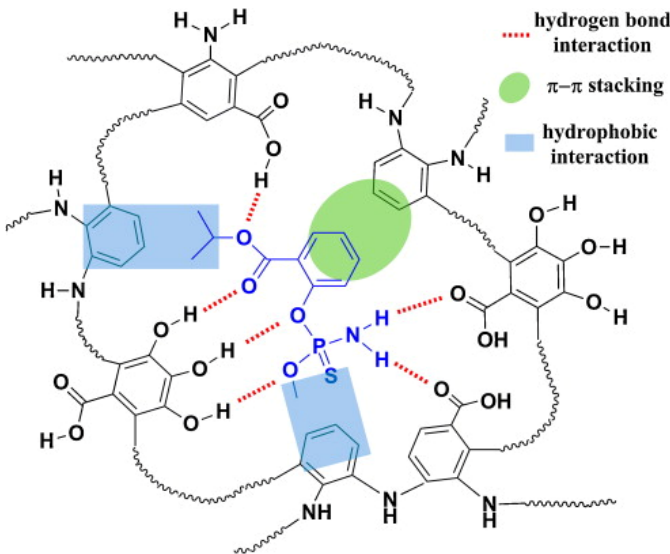
Figure 18. Schematic representation of the specific recognition of isocarbophos by a functionalized cavity of the terpolymer matrix based on poly( o -phenylenediamine-co-gallic acid-co- m -aminobenzoic acid). Reprinted from [105] with permission from Elsevier.